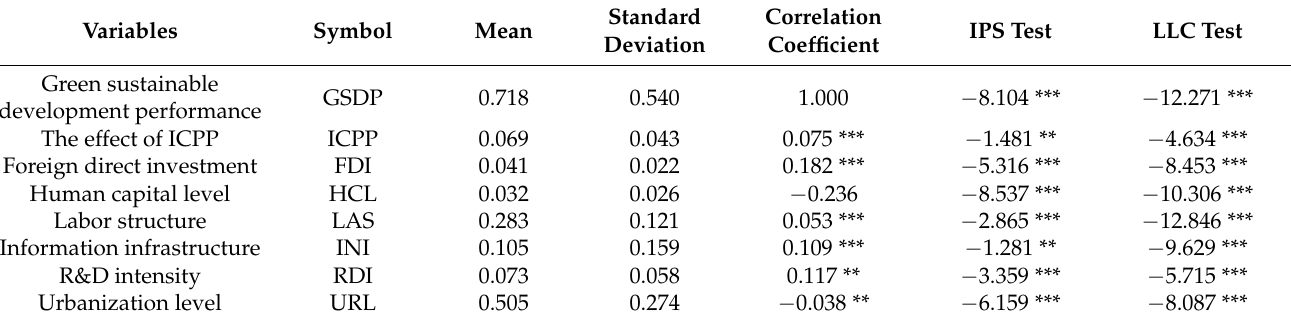
Table 2. Results of the descriptive analysis, correlation analysis, and unit root